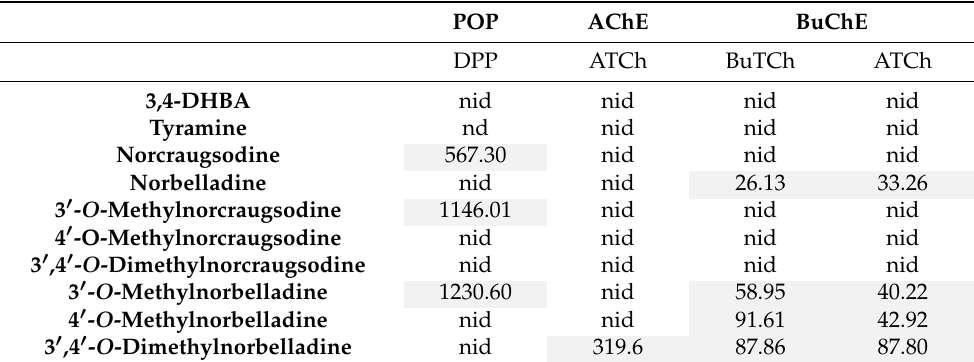
Table A1. Inhibitory properties (IC 50 values) of norbelladine precursors and derivatives toward enzymes implicated in Alzheimer’s